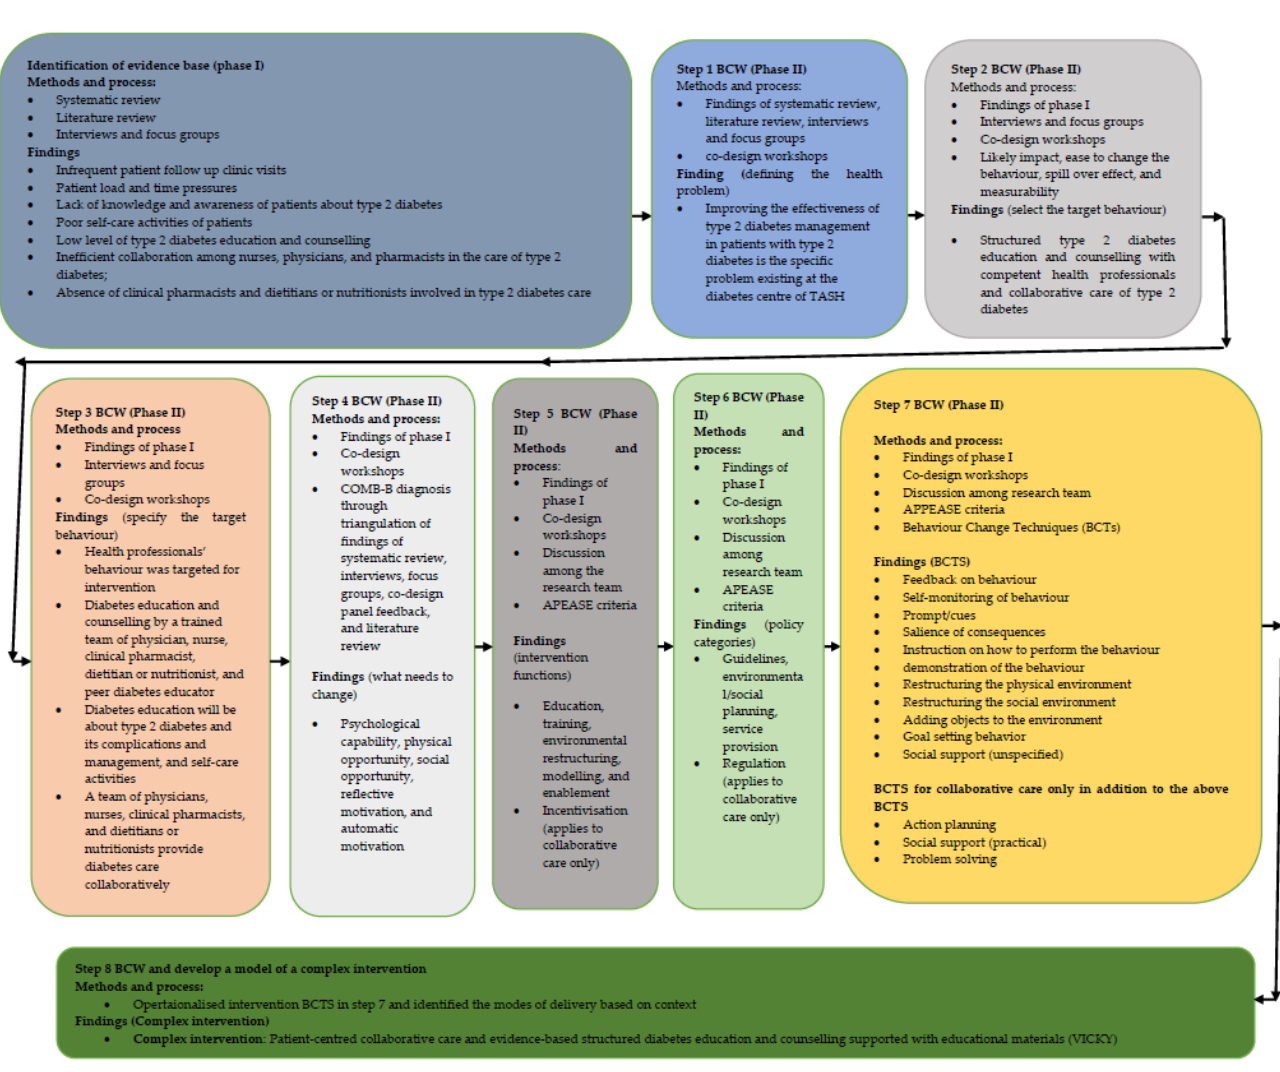
Figure 4. The processes involved in modelling and creating the complex intervention. The complex intervention (VICKY) consisted of five components (Table 1). Table 1. Components and intervention plan of the complex (VICKY) intervention. Components of the Complex Intervention (VICKY) Intervention Plan and Activities